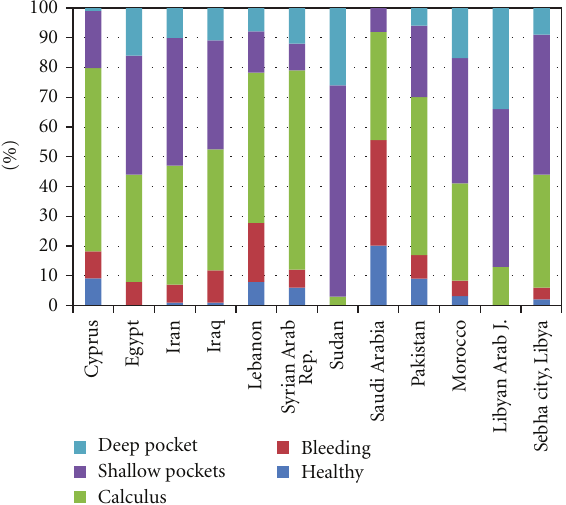
Figure 1: Percentage distribution of the subjects as per the CPI codes. Figure 2: Overview of periodontal status of 35–44 year old from di ff erent EMRO countries. Data obtained from WHO, Global oral data bank. Sebha city, Libya-present